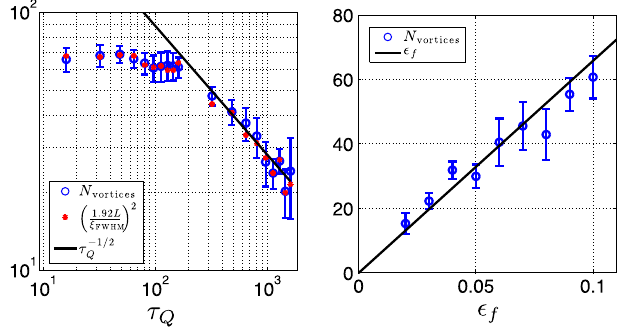
FIG. 5. Left: The number of vortices N and ξ − 2 at time vortices FWHM t ¼ t as a function of τ expressed in units of T (B15). Each Q c eq data point is computed by averaging the number of vortices over an ensemble of solutions at fixed τ . The error bars are computed Q from the variance of N . The numerical results are consistent vortices > 200 . For τ < 200 , our numerics with KZ scaling τ − 1 = 2 for τ Q Q Q are consistent with N const, which is consistent with our vortices ¼ expectation that the density of defects should asymptote to a constant in the limit of sudden quenches. Also included is a plot 2 , where L is our box size and B ≈ 1 . 92 . Our t of ½ LB= ξ FWHM ð eq Þ(cid:4) statistics are not sufficient to resolve the logarithmic prefactor in ϵ ð T (3.5). Right: N vs ϵ , in units of T (B15) for f ¼ f Þ c vortices sufficiently small τ . The results are consistent with (3.8) with Q ∼ ϵ N . Our statistics are again not sufficient to resolve the f vortices logarithmic prefactor in